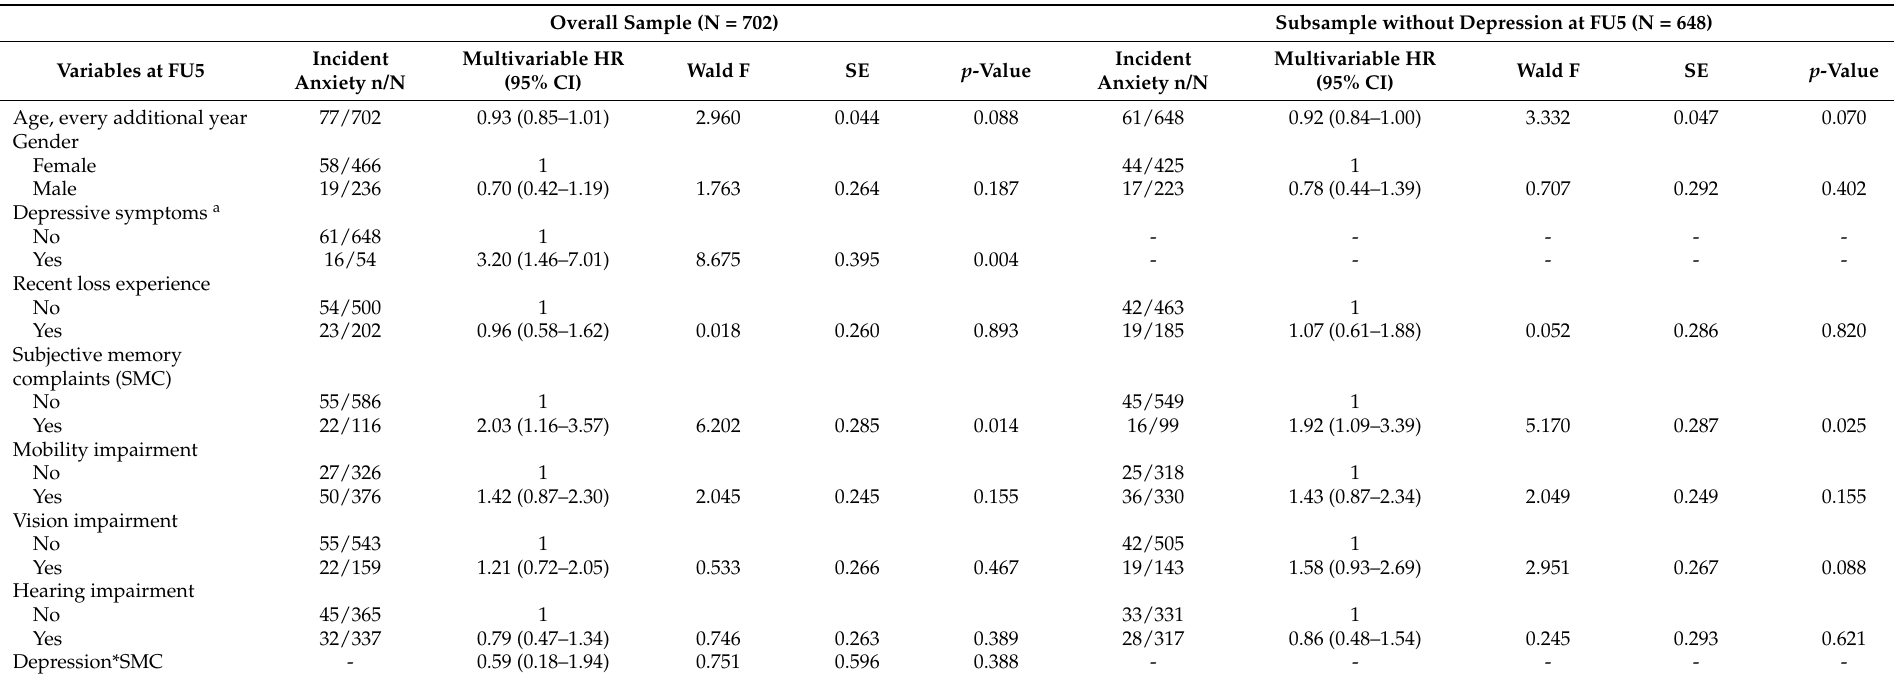
Table 3. Multivariable cox proportional hazards regression of time to incident anxiety for the overall sample and a subsample without depression at FU5. Overall Sample (N =